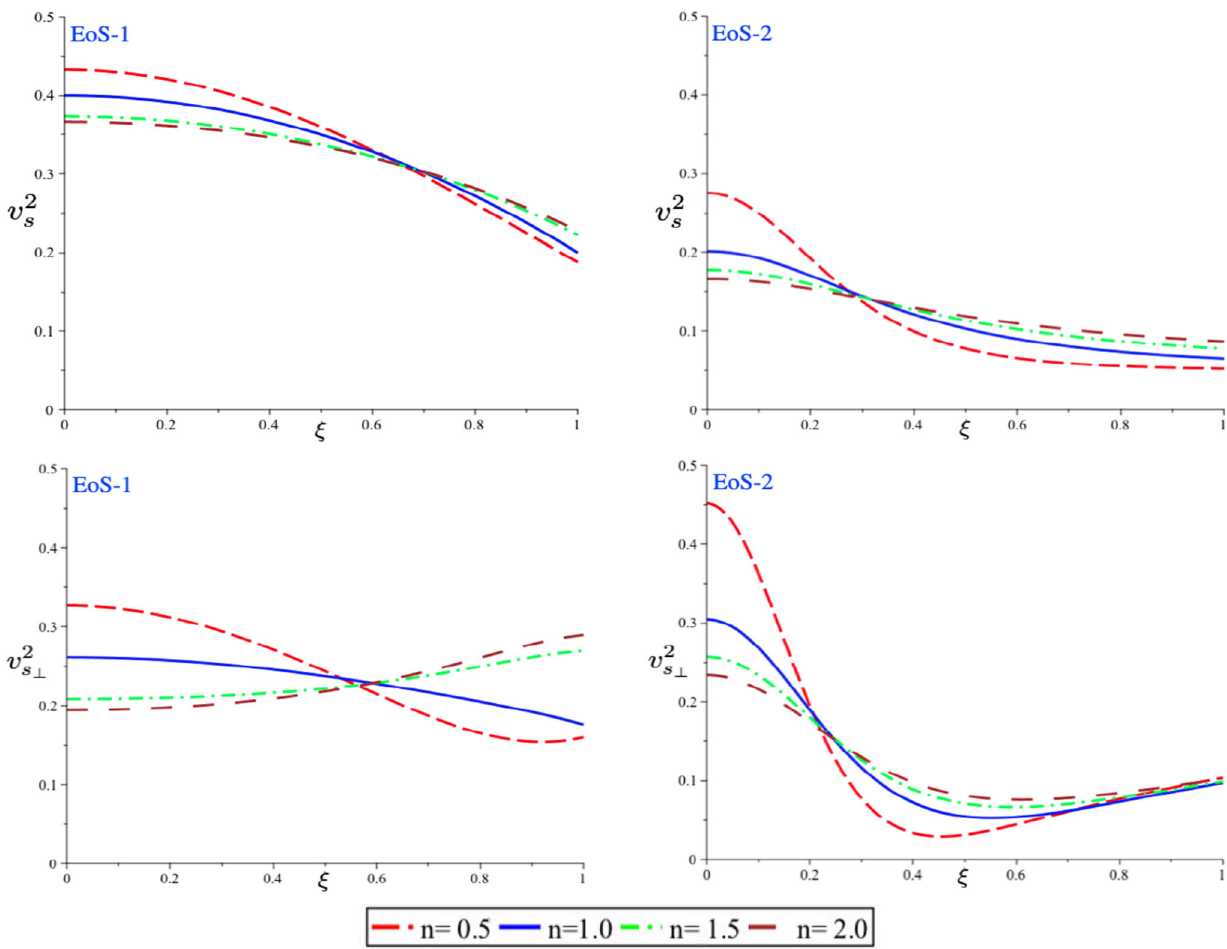
In both cases, the radial sound velocity is a monotonically decreasing function. Condition C6 is satisfiedby not exceedingthe velocityof light and the tangential velocity of sound has a finite value on the surface of the star